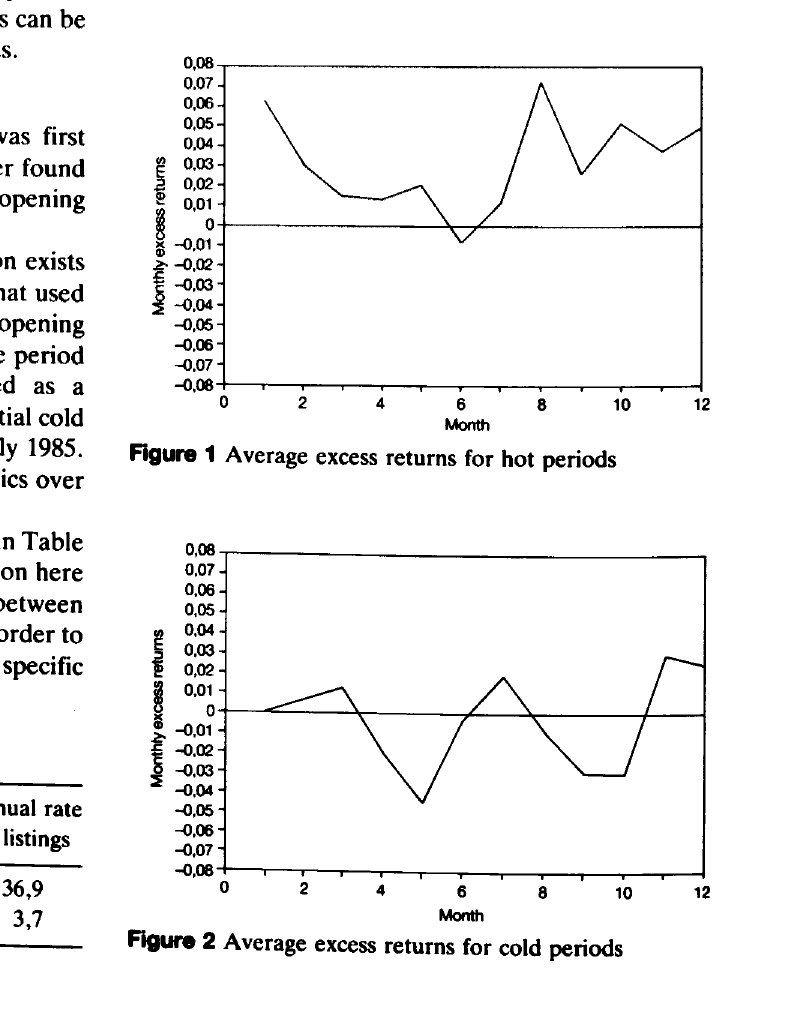
Figure 2 Average excess returns for cold